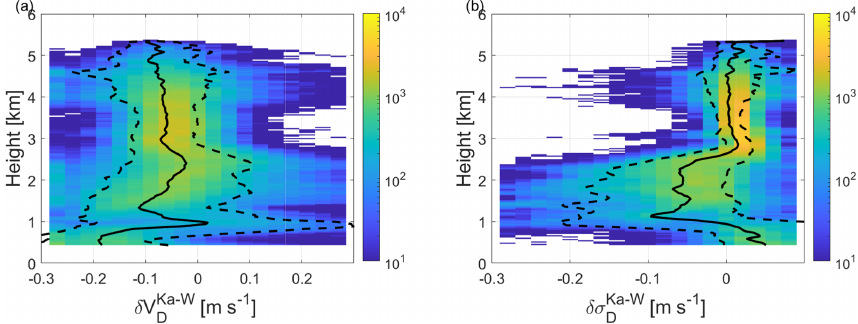
and differential spectral width δσ Ka , W between D D